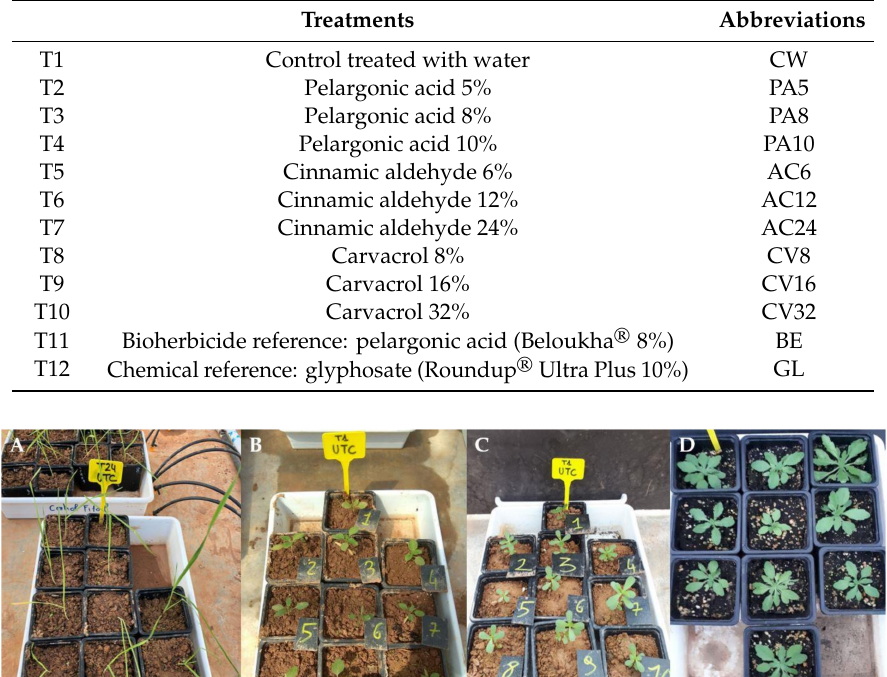
Table 2. Treatments tested.